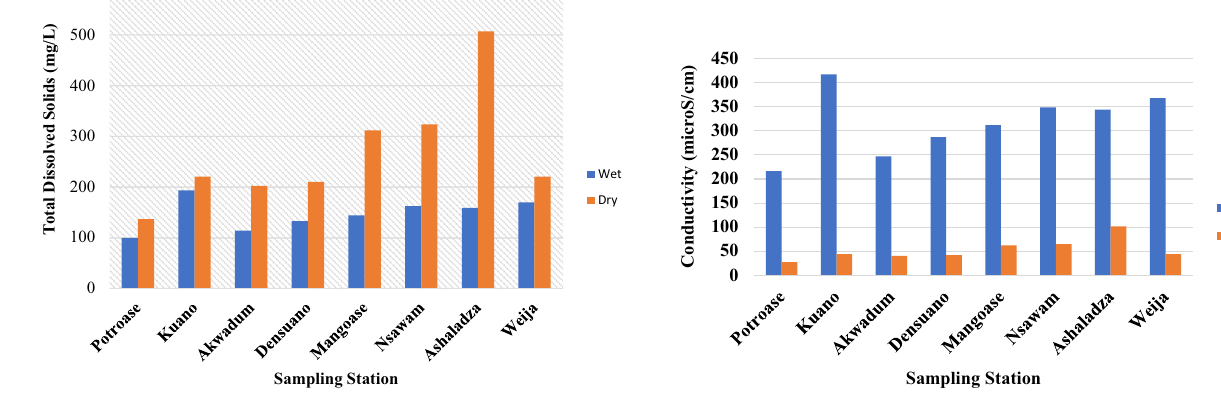
Fig. 4 Total dissolved solids for wet and dry seasons Fig. 5 Electrical conductivity for wet and dry